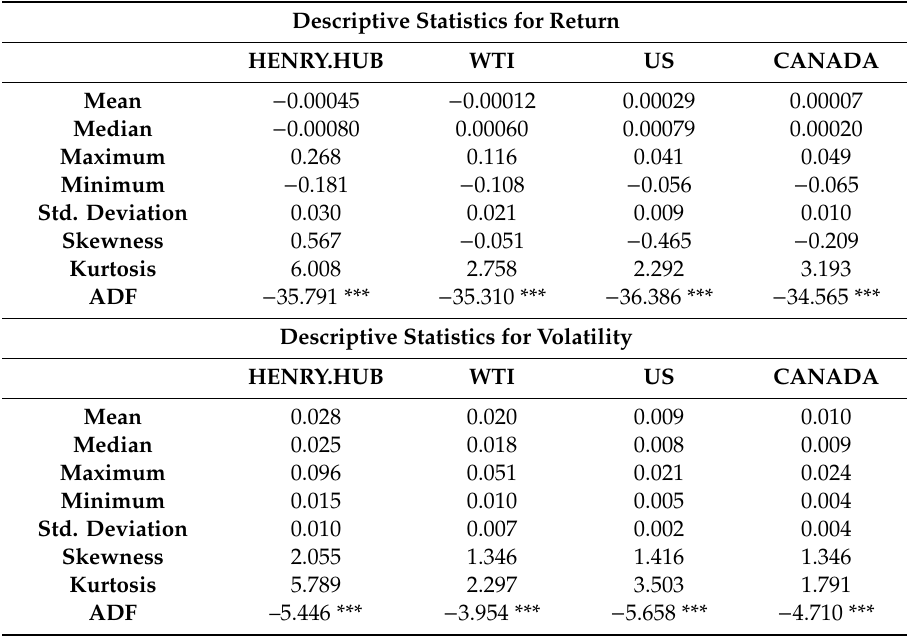
Table 2. Descriptive statistics of the return and volatility series in North America.